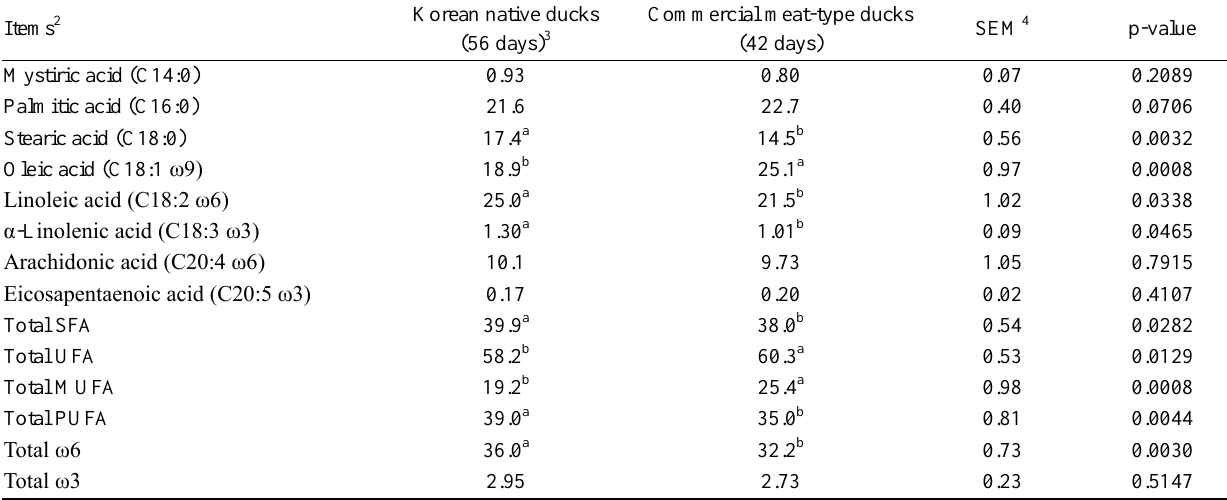
Table 5. Fatty acid composition of the breast meat from the Korean native ducks and commercial meat-type ducks